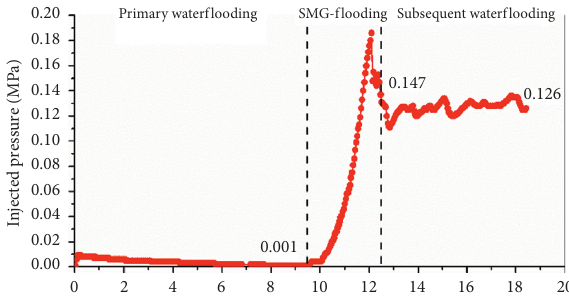
Figure 8: Pressure curve of submillimeter-scale SMG plugging property test. The resistance factor ( F are 147 and 126. The value of these parameters is positively correlated with injection volume of SMG aqueous